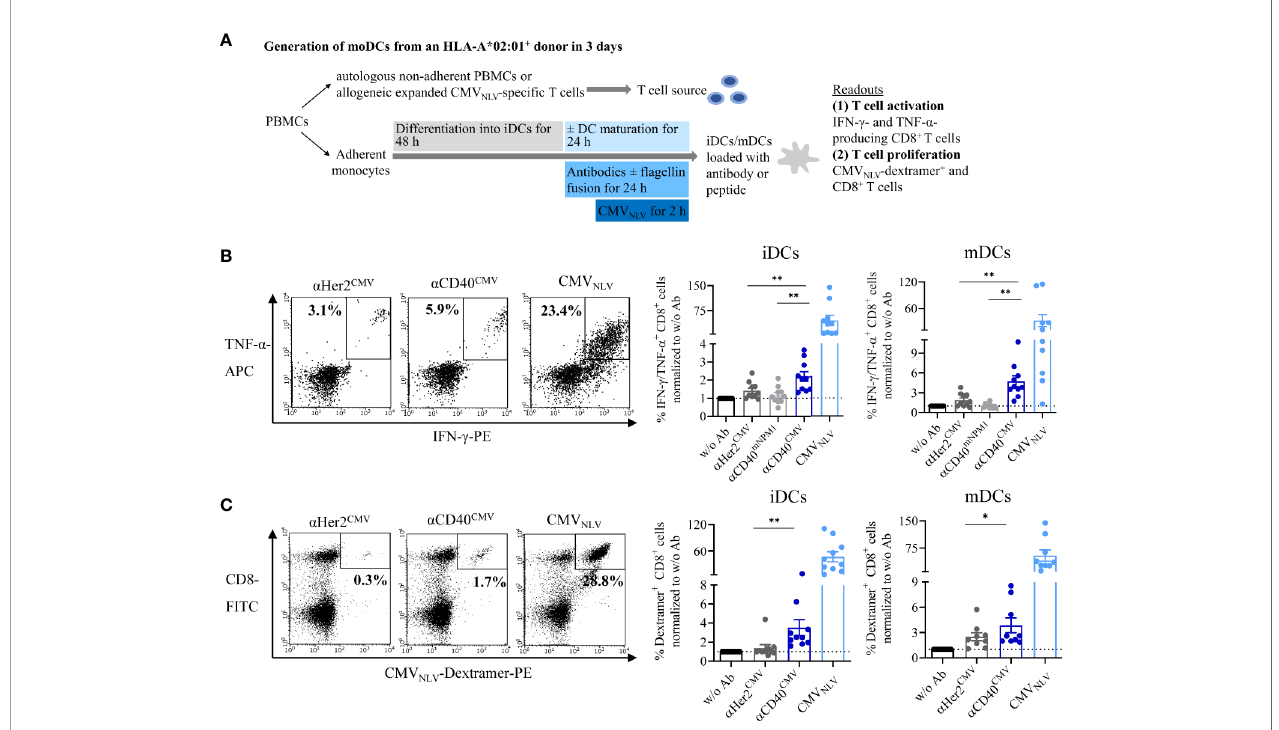
FIGURE 4 | a CD40 CMV loaded DCs ef fi ciently cross-presented the peptides on the surface and induced activation and proliferation of antigen-responsive T cells. (A) Co-cultures of iDCs/mDCs and allogeneic CMV NLV -speci fi c T cells or with autologous NACs from HLA-A*02:01 + donors with a preceding CMV infection. DCs were pre-incubated with different antibody constructs or with peptide controls. In the allogeneic setting, T cell activation was analysed by counting IFN- g - and TNF- a - producing CD8 + cells. In the autologous setting, T cell proliferation was determined by CMV NLV -speci fi c dextramer staining of CD8 + T cells. (B) Co-culture of allogeneic CMV NLV -speci fi c T cells and HLA-A*02:01 + iDCs or mDCs. The DCs were pre-incubated with a Her2 CMV , a CD40 CMV , a CD40 conjugated to a control peptide ( a CD40 mNPM1 ) or with the processed CMV NLV peptide. As a readout, T cell activation was measured by fl ow cytometry ( n = 10 donors). (C) Co-culture of autologous NACs with iDCs and mDCs pre-loaded with a Her2 CMV , a CD40 CMV and the processed CMV NLV peptide. As readout, T cell proliferation was analysed by fl ow cytometry ( n = 10 donors). T cell activation and proliferation are normalized to w/o Ab for each donor, respectively. Bars represent mean ± SEM. For statistical analysis, a Wilcoxon-signed rank test was applied. * p < 0.05, ** p <